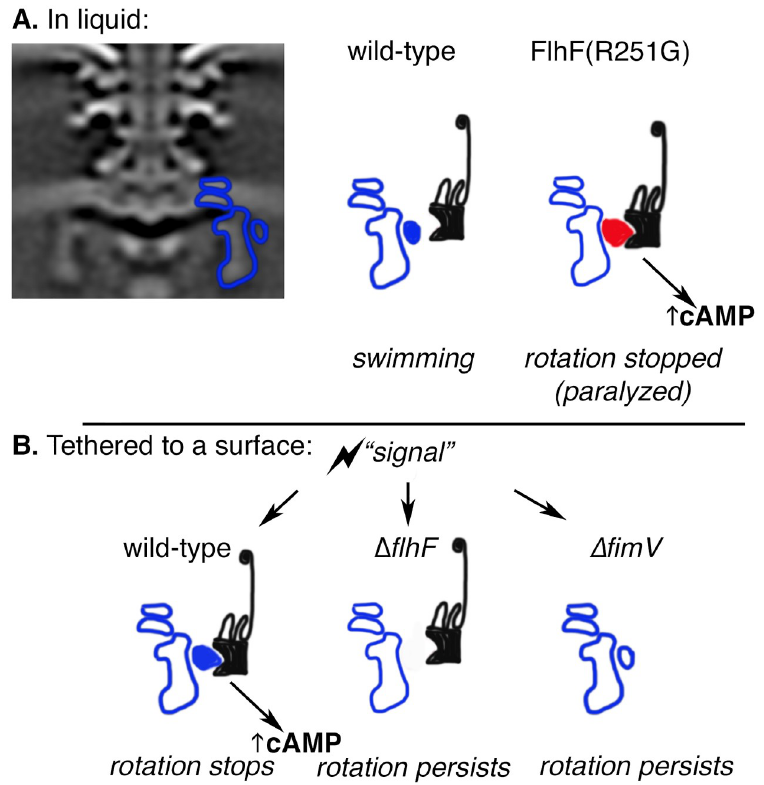
Fig 8. FlhF-FimV interaction is upstream of a cAMP signal in surface-tethered bacteria. A. The P . aeruginosa flagellar motor C-ring (outlined in blue) interacts with FlhF (blue solid oval) by bacterial 2-hybrid. A GDP-locked allele of FlhF, FlhF(R251G), has stronger and/or more persistent interaction with FimV. This causes an inappropriate cAMP increase in liquid-grown bacteria that inhibits flagellar rotation. B. When bacteria tether at a surface, an undefined “signal” causes a conformational change in FlhF that allows it to interact with FimV. This leads to an increase in intracellular cAMP that stops flagellar rotation and promotes bacterial cell body attachment to a surface. If either FlhF or FimV are absent, the interaction does not occur, cAMP levels do not rise, and bacterial rotation persists in surface-tethered